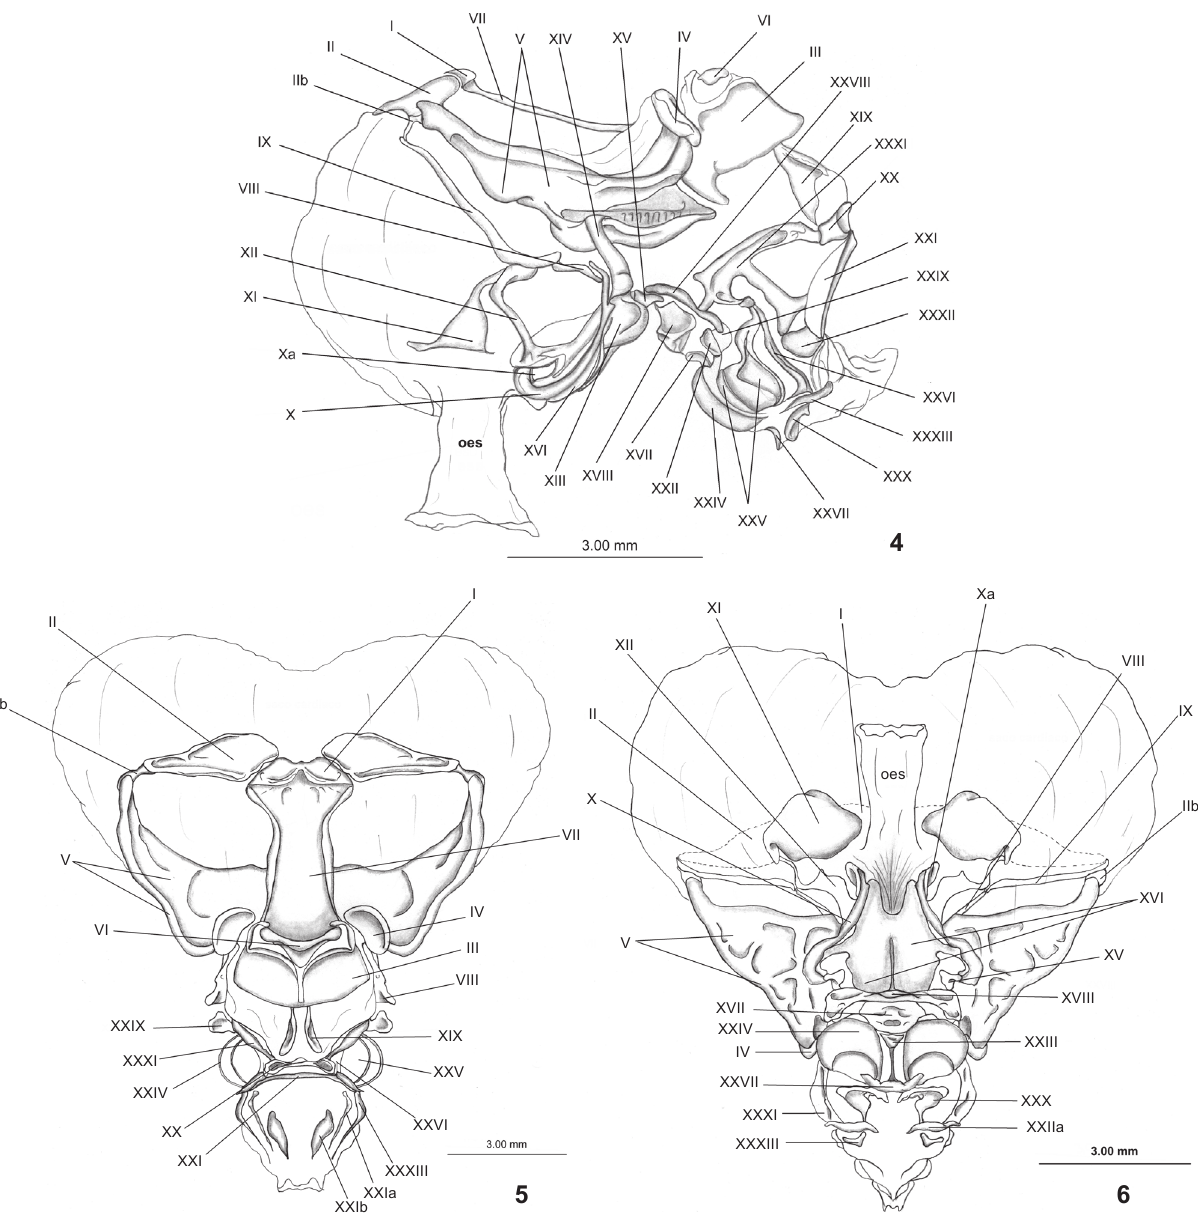
Figures 4-6. Sylviocarcinus pictus , cardiac and pyloric chambers of the foregut: (4) lateral view; (5) dorsal view; (6) ventral view. Mesocardiac ossicle (I), pterocardiac ossicle (II), postpterocardiac ossicle (IIb), pyloric ossicle (III), exopyloric ossicle (IV), zygocardiac ossicle (V), propyloric ossicle (VI), urocardiac ossicle (VII), pectineal ossicle (VIII), prepectineal ossicle (IX), postpectineal ossicle (X), ‘Quill’ of the postpectineal ossicle (Xa), anterior lateral cardiac plate (XI), posterior lateral cardiac plate (XII), inferior lateral cardiac ossicle (XIII), subdentate ossicle (XIV), lateral cardio-pyloric ossicle (XV), ossicle of the cardio-pyloric valve (XVI), anterior ossicle of the cardio-pyloric valve (XVI), posterior ossicle of the cardio-pyloric valve (XVII), lateral ossicle of the cardio-pyloric valve (XVIII), anterior mesopyloric ossicle (XIX), posterior mesopyloric ossicle (XX), uropyloric ossicle (XXI), preampullary ossicle (XXII), inferior ampullary ossicle (XXIV), ampullary roof ossicle, lower portion ossicle (XXV), ampullary roof ossicle, upper portion ossicle (XXVI), posterior inferior pyloric ossicle (XXVII), anterior supra-ampullary ossicle (XXVIII), middle supra-ampullary ossicle (XXIX), posterior supra-ampullary ossicle (XXX), ante- rior pleuropyloric ossicle (XXXI), middle pleuropyloric ossicle (XXXII), posterior pleuropyloric ossicle ZOOLOGIA 27 (2): 228–244, April, 2010